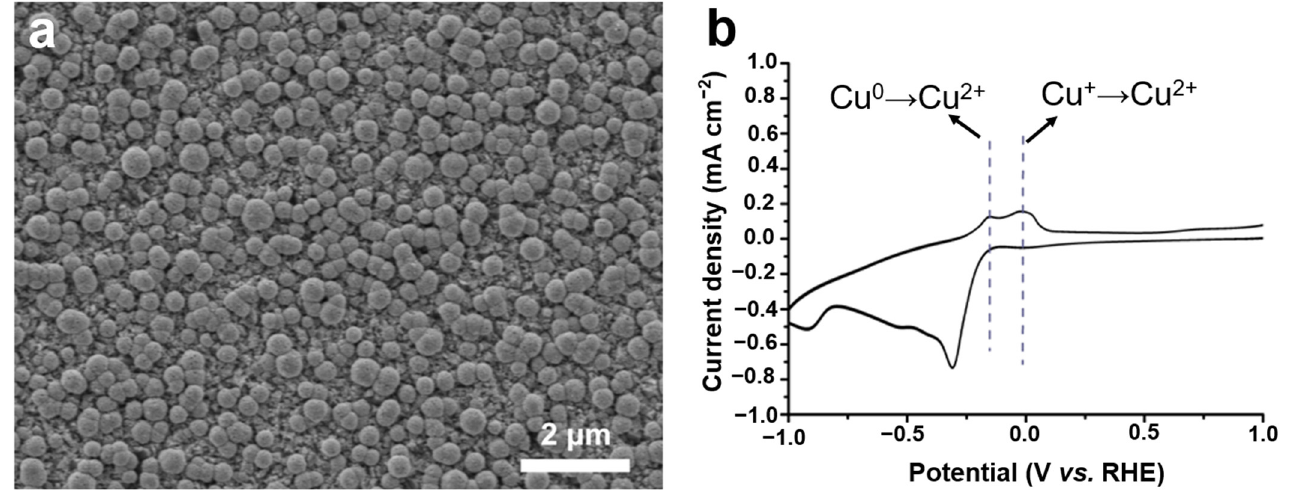
Figure 11. SEM images of Cu 0.6 after the CO 2 RR (6 h) ( a ).CV for Cu 0.6 as anode after CO 2 RR at − 0.6 V vs. RHE ( b ).